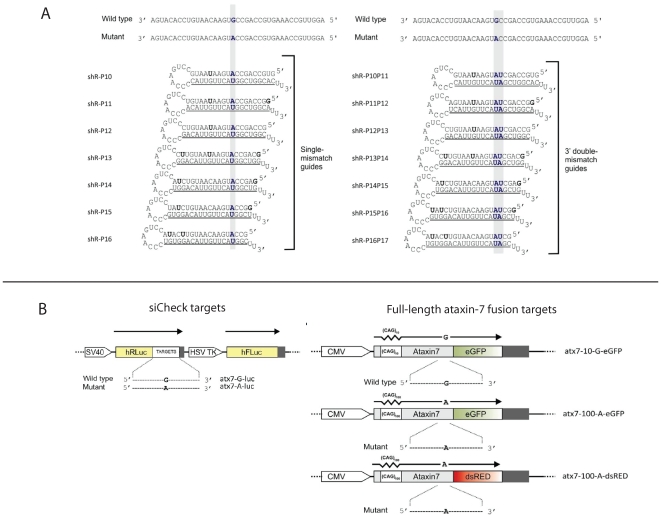
RNAi-based shRNAs and target vectors designed for atxn7 knockdown.(A) Convention for the diagram follows Schwarz and colleagues (16). Sequences of expected single and double mismatch guide strands (underlined) processed from an shRNA format indicating the site of the primary mismatch to the G allele of the wild-type atxn7 target. Sequence context of both the wild-type and mutant targets are shown. Functional asymmetry was induced by creating G:U mis-pairings in the 3′ end of the anti-guide strand; these are highlighted in bold. The shRNAs were labelled according to the position of the primary mismatch relative to the 5′ end of the guide strand; followed by any additional mismatches. The nomenclature is based on a 21bp guide strand after cleavage of the anti-sense strand by Dicer. (B) Schematic representations of the fused target-reporter cassettes. atx7-G-luc and atx7-A-luc are the wild-type and mutant reporter siCHECK plasmids used in the luciferase assay, and included a short region of 60 bp of atxn7 target sequence spanning the SNP fused to the Renilla luciferase reporter gene. atx7-10-G-eGFP, atx7-100-A-eGFP, atx7-100-A-DsRED are the 3 reporter plasmids used in the full-length hemi- and heterozygous assays and consist of the full-length atxn7 cDNA. The wild-type construct (atx7-10-G-eGFP) has a CAG repeat length of 10 incorporating the G allele of the SNP, fused to eGFP. The two mutant constructs (atx7-100-A-eGFP, atx7-100-A-DsRED) have CAG repeat lengths of 100, as well as the A allele of the SNP, and are fused to eGFP and DsRED respectively.